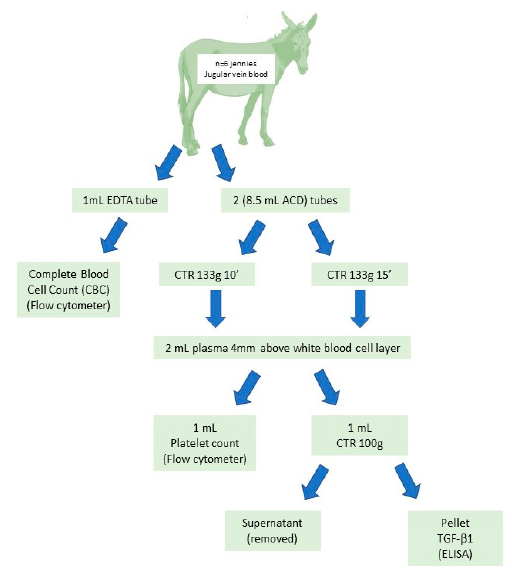
Figure 1. Experimental design.